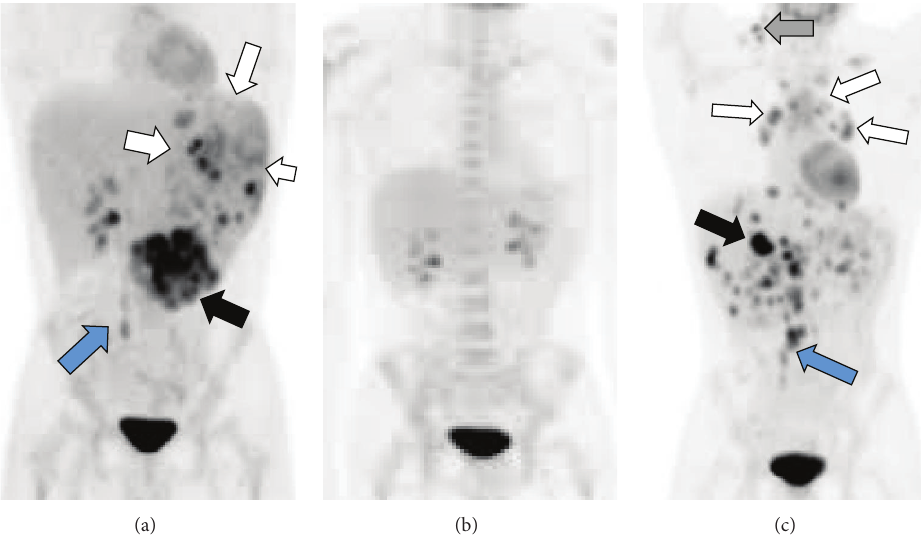
Figure 1: PET scans. (a) Prechemotherapy PET-CT scan (anterior view) demonstrates marked splenomegaly (white arrows), with multiple hypermetabolic foci scattered throughout the spleen and in the retroperitoneum (blue arrow). There was a large aggregate of abnormal foci at the lower edge of the spleen that measured 7 × 6 × 5 cm (black arrow); (b) PET-CT after 6 cycles of CHOP chemotherapy shows no evidence of disease; (c) recurrent hypermetabolic foci and lymphadenopathy involving multiple sites within the liver (black arrow), peritoneum (blue arrow), mediastinum (white arrows), and neck (gray